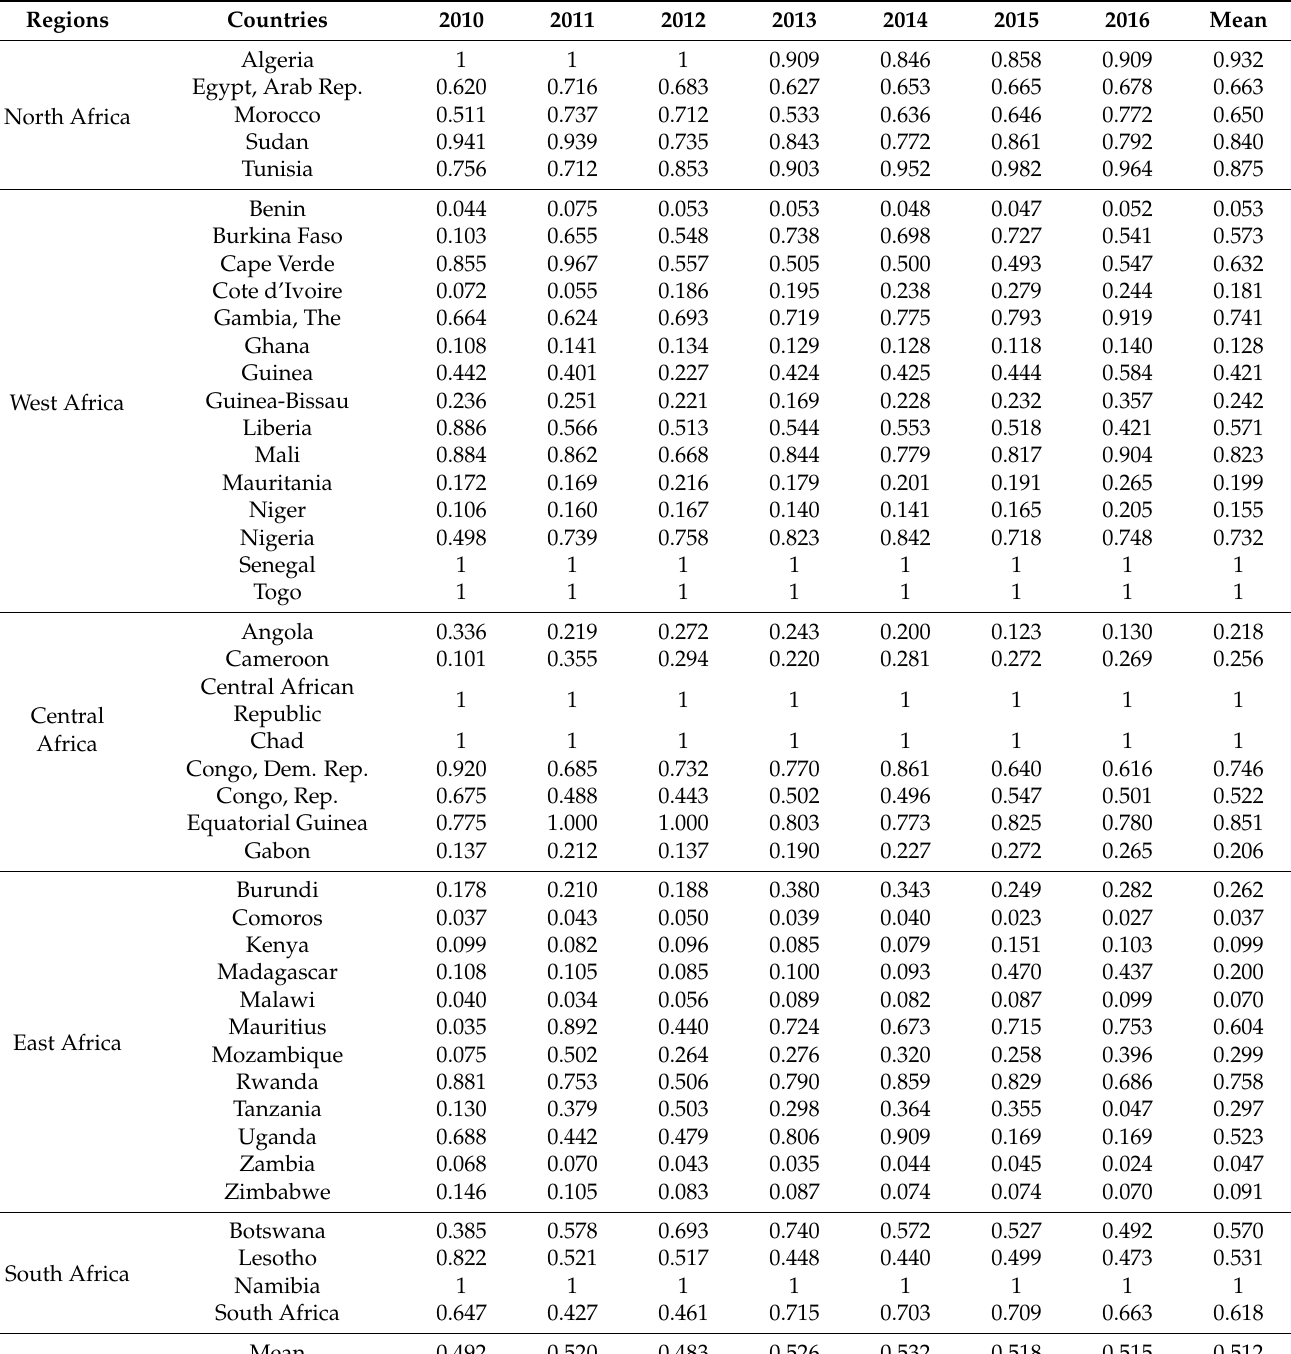
Table 7. Technology gap ratio (TGR) regarding DSTFEE in